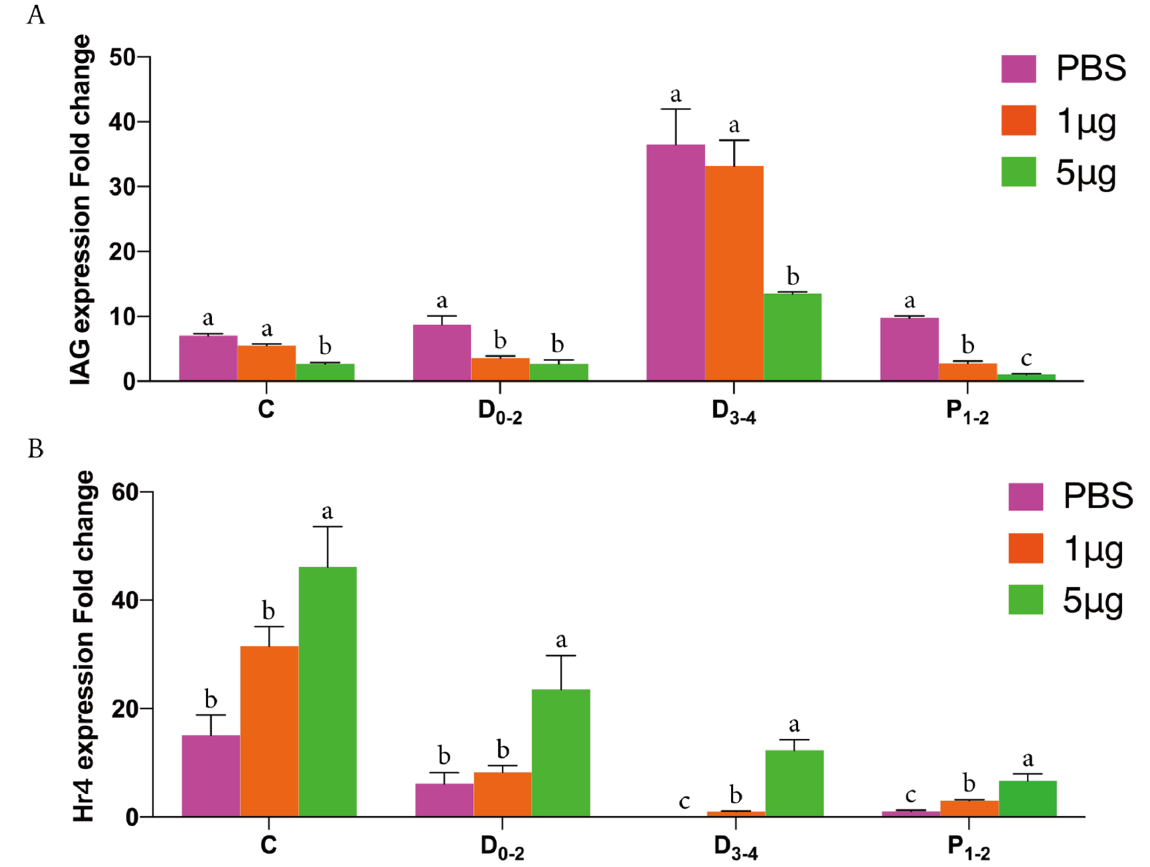
Figure 3. The 20E injection regulated the expression of Lv-IAG ( A ) and Lv-Hr4 ( B ) throughout the molting cycle. Two dosages of 20E (1 μ g and 5 μ g per individual, respectively) were used, and an equal volume of PBS was injected as a negative control. Data are represented as means and standard deviations. Statistical differences were determined using Student’s t- test. The different letters indicate significant differences in the gene expression level at the same molt stage (n = 3).